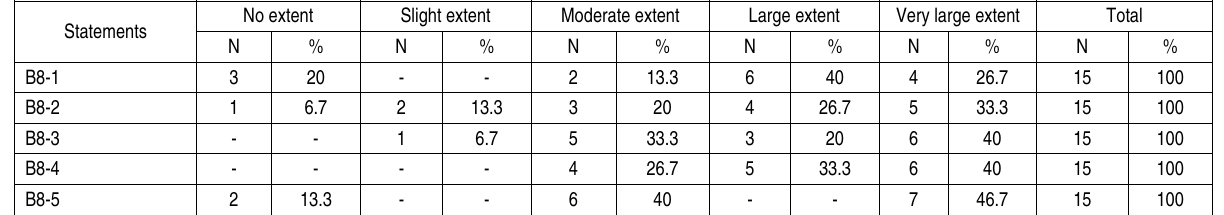
Table 10. Perceptions of the respondents on the statement relating to risk management